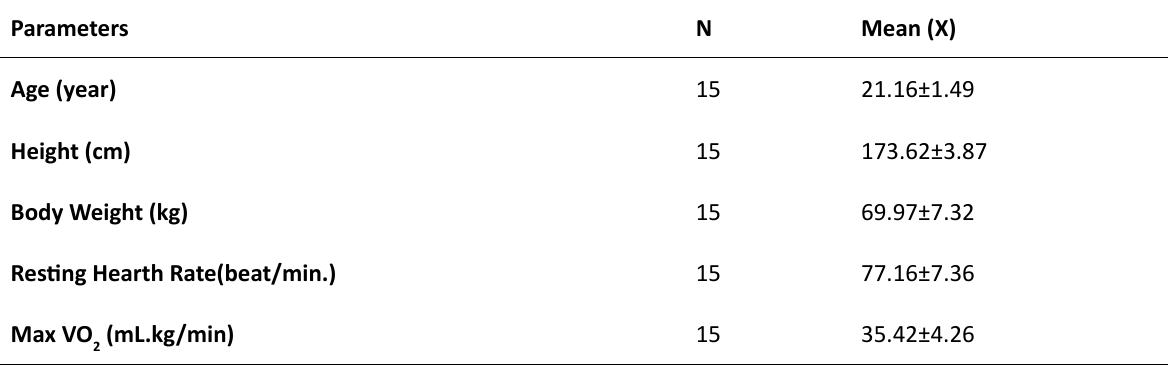
Table 1. Some of physical and physiological parameters of the participants